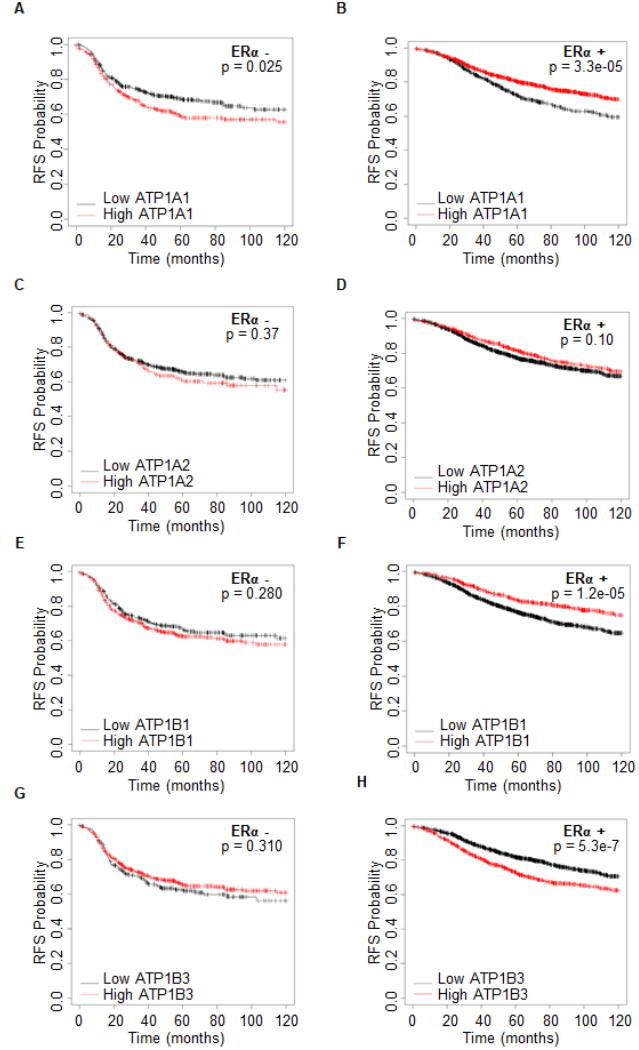
Figure 4. The expression of Na/K ATPase isoforms in breast cancer progression. Kaplan–Meier plots show the relapse-free survival (RFS) probability in women carrying ER α -negative ( A , C , E , G ) or ERα -positive ( B , D , F , H ) as a function of the mRNA levels of the indicated genes. All possible cutoff values between the lower and upper quartiles are automatically computed (i.e., auto-select the best cutoff on the website), and the best-performing threshold is used as a cutoff [18] . Details of the parameters of the curves are given in Supplementary Table S4. Significant differences between the RFS are given as p -value in each panel. All possible cutoff values between the lower and upper quartiles are automatically computed (i.e., auto-select the best cutoff on the website), and the best-performing threshold is used as a cutoff.